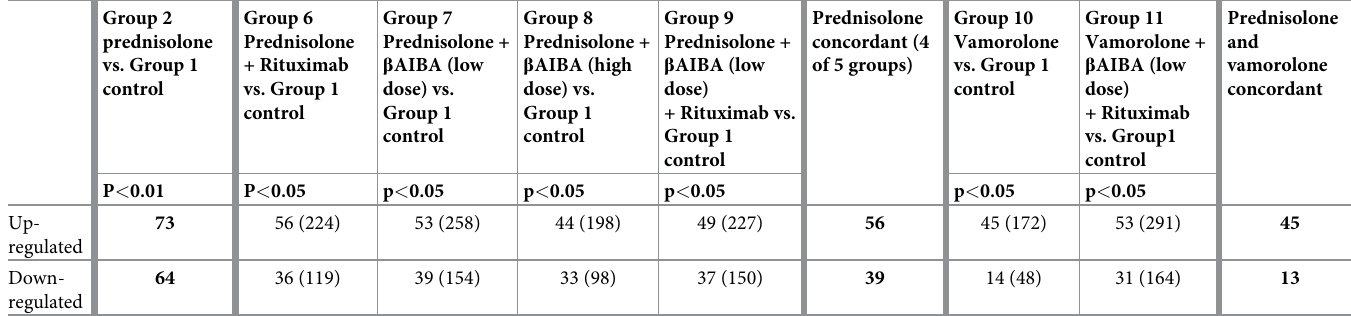
Table 3. Serum proteomics comparisons of drug-treated vs. non-treated controls (Group 1) for prednisolone-treated and vamorolone-treated mdx mice. Group 2